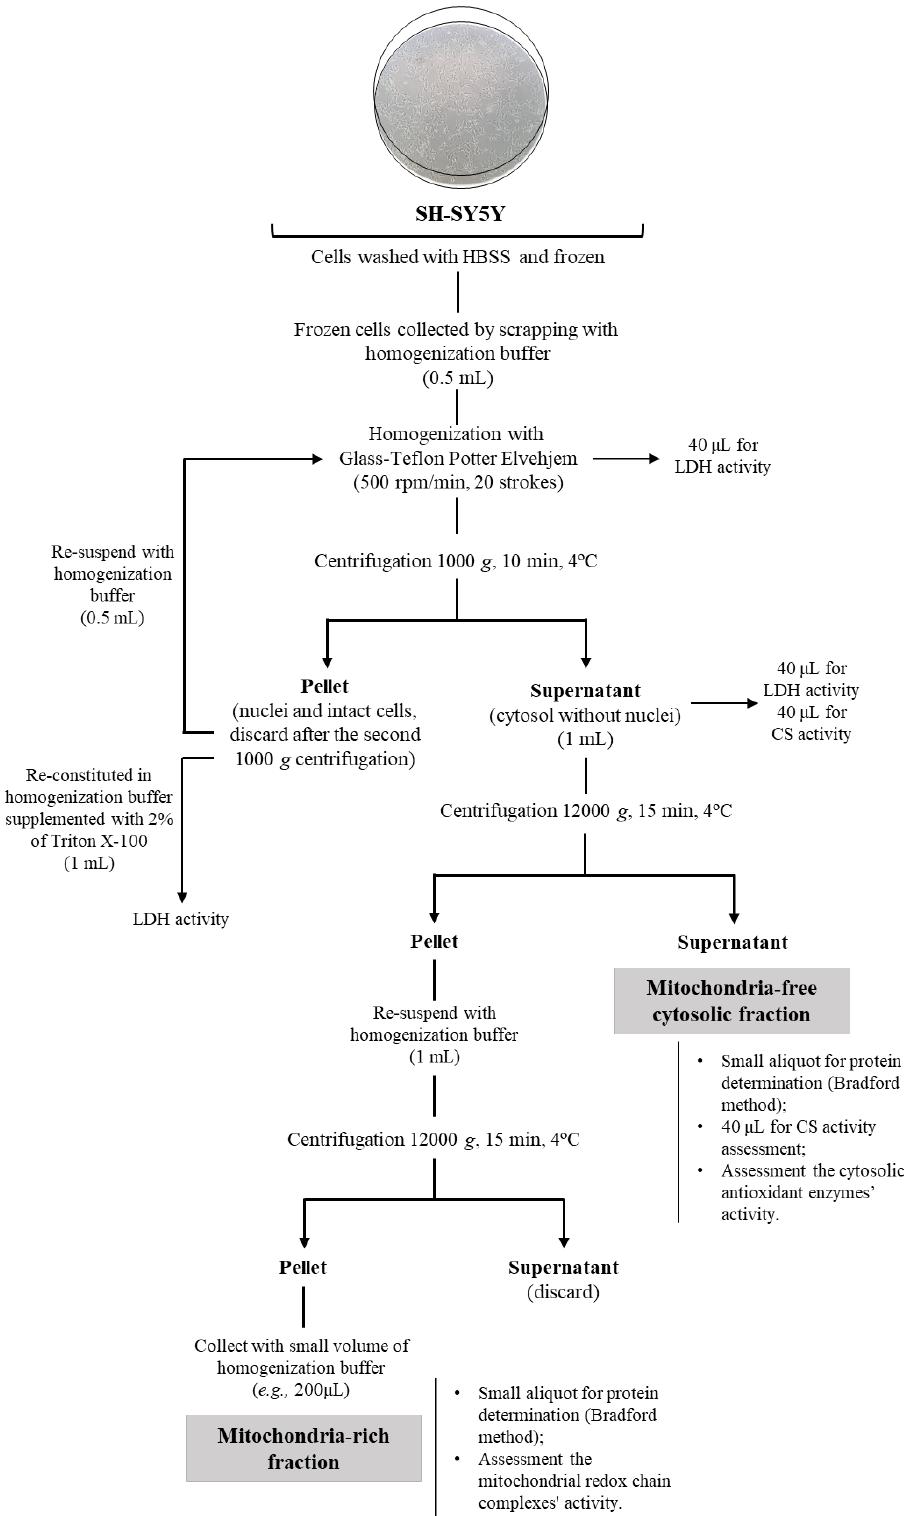
Figure 2. Flow diagram representing the fractionation of cell pellet in mitochondria-free cytosolic and mitochondria-rich fractions on cell cultures by differential centrifugation.